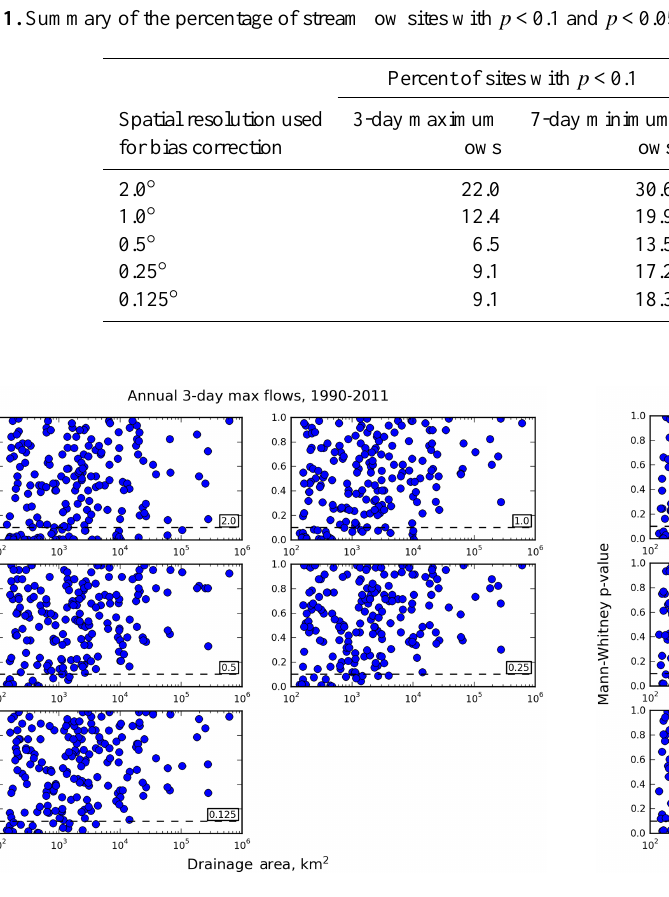
Figure 9. Similar to Fig. 8, but for the 7-day low flows at each streamflow